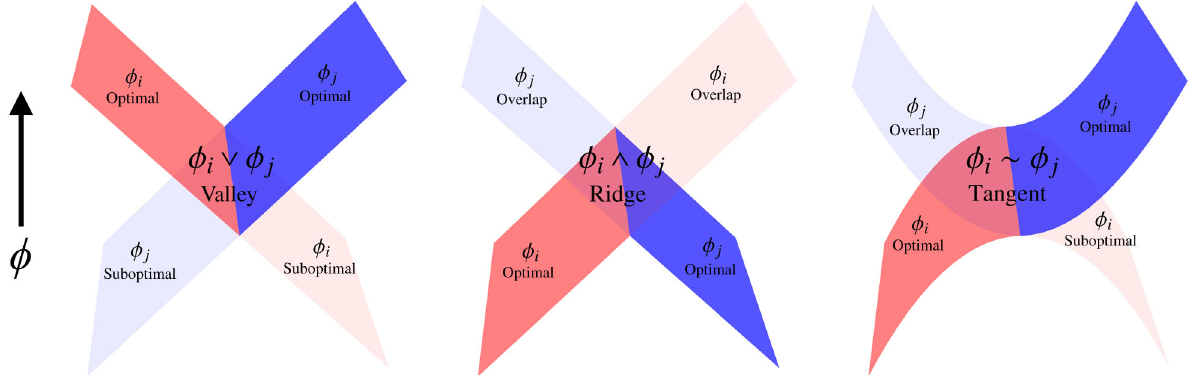
FIG. 4 Boundaries between adjacent regions of topologically distinct packings are classified into three boundary types: valley (left), ridge (middle), and tangent